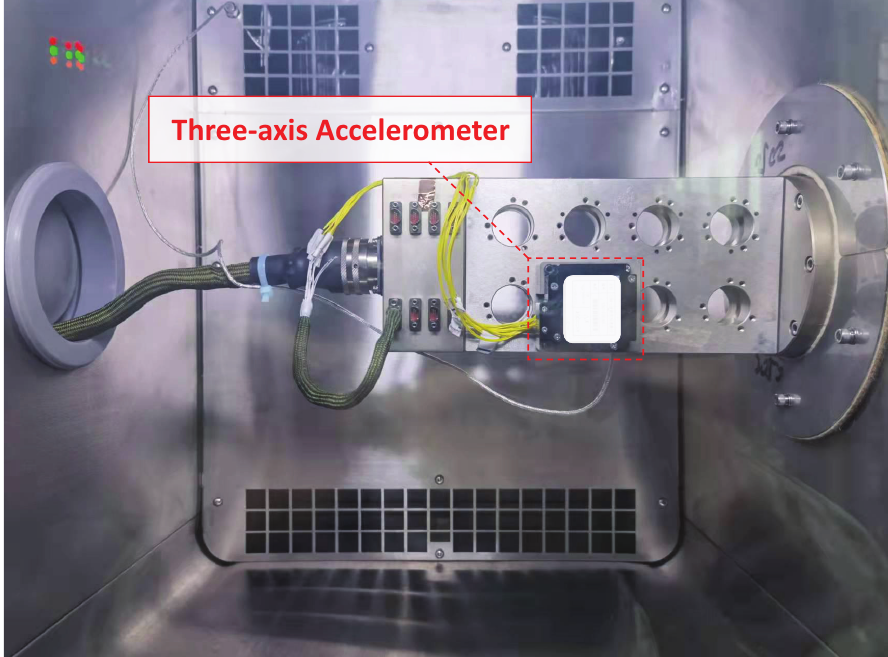
Figure 3. Experimental platform of accelerometer for temperature